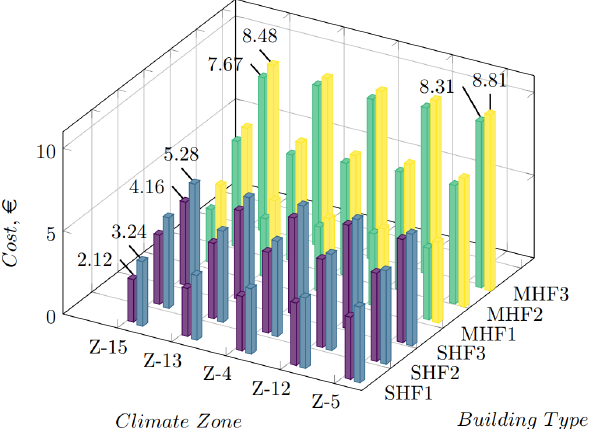
Figure 11. Cost comparison between full-load (left column, purple, and green) and partial-load operation (right column, blue, and yellow) for different climate zones and building types, for a UWB typical day (intermediate season, working day, cloudy).